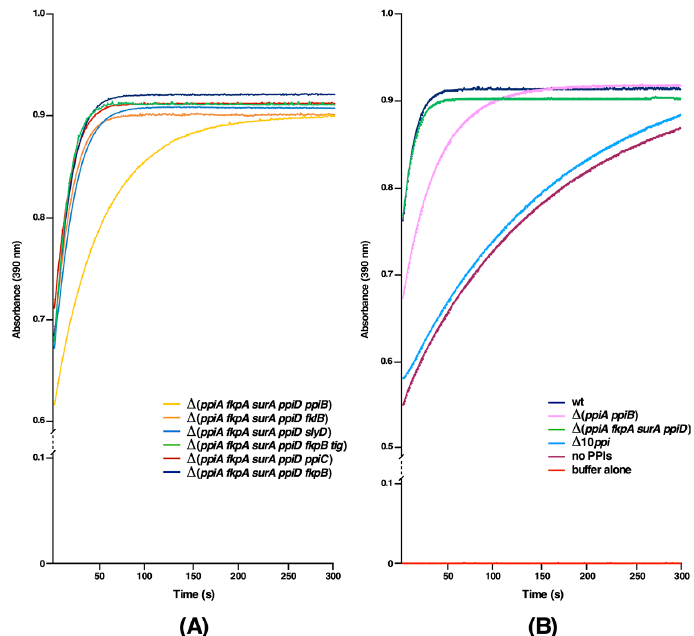
Figure 2. PpiB is the major contributor of PPIase activity in the cytoplasm. ( A ) The PPIase activity in soluble extracts obtained from six sets of strains lacking periplasmic PPIs and one of the cytoplasmic PPI were used to measure the PPIase activity, revealing that the absence of PpiB leads to highly reduced PPIase activity. In all cases, total protein concentration was 10 mg / mL and N-Suc-Ala-Ala-cis-Pro-Phe-p-nitroanilide was used as the substrate. The PPIase activity was measured in a chymotrypsin-coupled assay. ( B ) Under similar conditions, extracts from the wild type, ∆ ( ppiA ppiB ), ∆ ( ppiA fkpA surA ppiD ), ∆ 10 ppi strain lacking all PPIs were used to measure the PPIase activity.